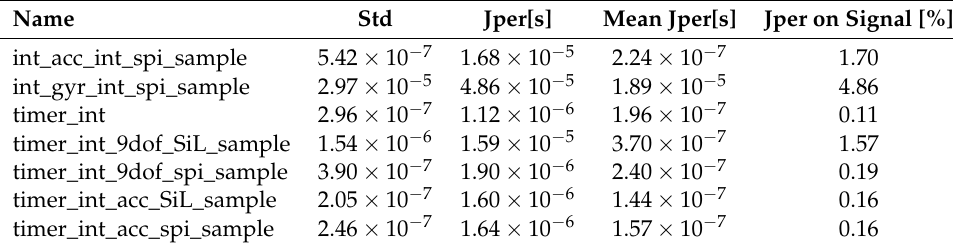
Table 7. Periodic Jitter without optimization (-O0).